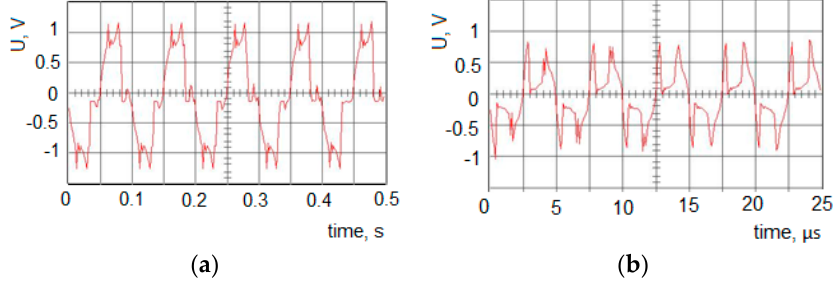
Figure 6. Oscillograms of the generated piezoelectric voltage at frequencies, corresponding to the low ( a ) and high ( b ) dielectric losses regions.